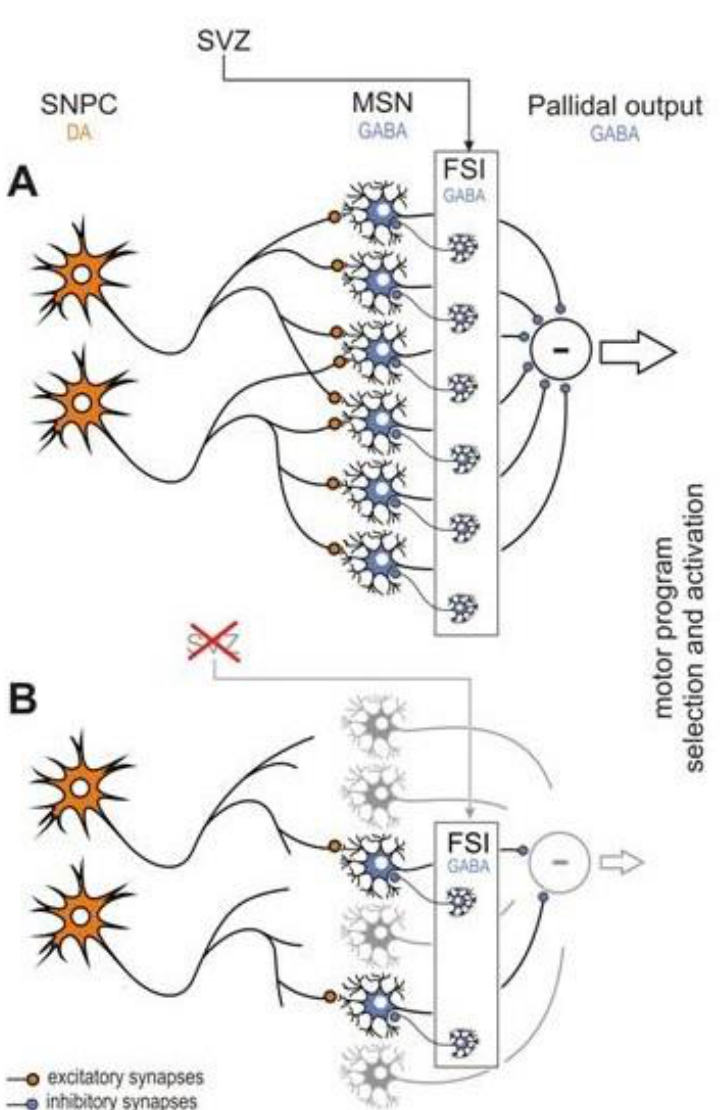
Figure 2. Model of the nigrostriatal interaction showing the physiology ( A ) and pathophysiology ( B ) of the striatum that may cause Parkinson’s disease [100]. In physiological conditions, the interaction is determined by the activity-dependent continuous turnover of GABAergic interneurons of the striatum. The fast-spiking interneurons (FSI) are particularly susceptible to apoptosis, thus, the physiological function of the striatum requires the continuous exchange of these interneurons. Normal activity of the striatum that is characterized by an elevated level of neurotransmitters (mostly GABA) and the glia-derived neurotrophic factor (GDNF) intensifies proliferation and migration of stem cells to the striatum. Both GABA and GDNF are chemoattractants for progenitor cells. The subventricular zone (SVZ) is a specialized brain area containing self-renewing GFAP + astrocytes functioning as neural stem cells that generate new interneurons in both the striatum and olfactory bulbs throughout life. Age-related decline inneurogenesis is followed by a decline in the nigrostriatal interaction resulting in progressive withdrawal and eventually, disconnection of the dopaminergic input from the substantia nigra pars compacta (SNpc). This initiates a ’vicious circle’ cascade of pathological events resulting in a devastating decline of nigrostriatal interaction that leads to fatal damage of the FSI turnover and neurodegeneration of the DOPA neurons of the SNpc. In this pathological state, the striatum loses its control over the pallidal output, and clinical symptoms of Parkinson’s disease such as hypokinesia and rigidity are observed. The model reproduced with permission from Błaszczyk 2017 [131]. Copyright 2017 Acta Neurobiologia Experimentalis.